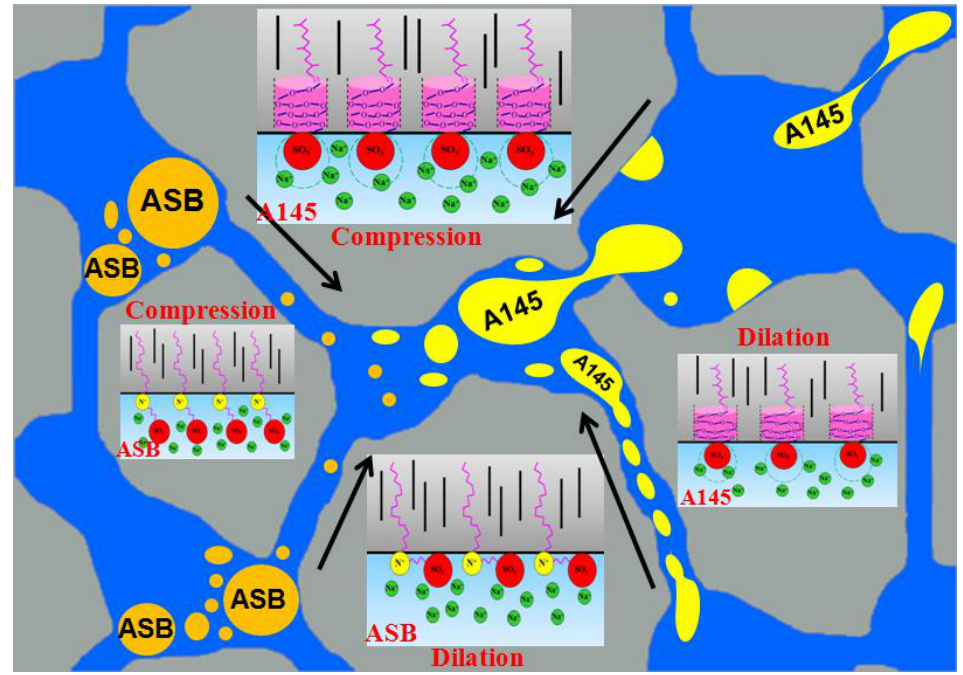
Figure 12. Schematic diagram of the arrangement of surfactant molecules on oil-water interface before and after the droplets pass through pore throat.